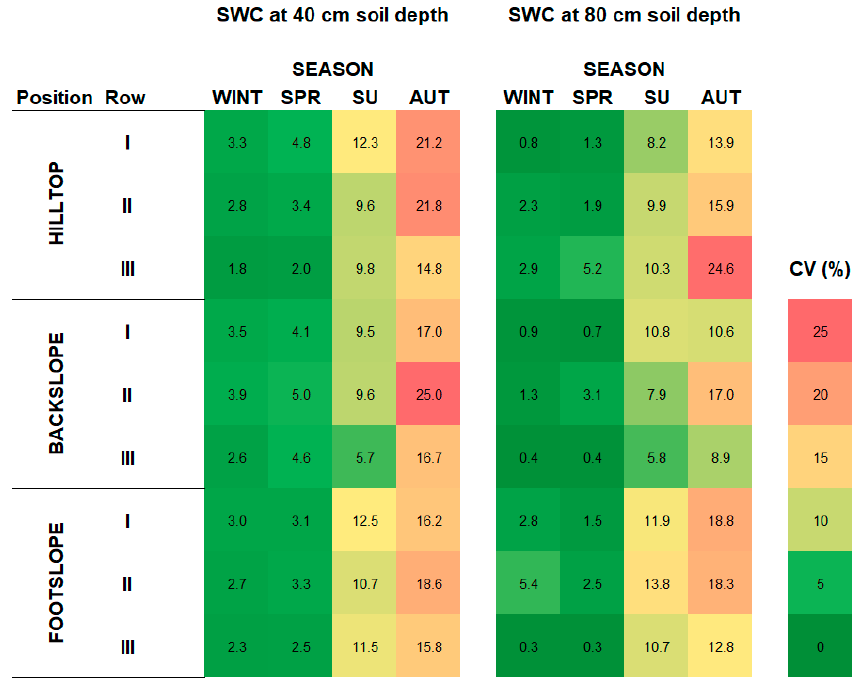
Figure 7. Heatmap of coefficients of variation (CV) [%] for soil water content (SWC) at the at two depths (40 and 80 cm), in three vineyard rows, along the hillslope (hilltop, backslope and footslope) in 2021 at the SUPREHILL Critical Zone Observatory.